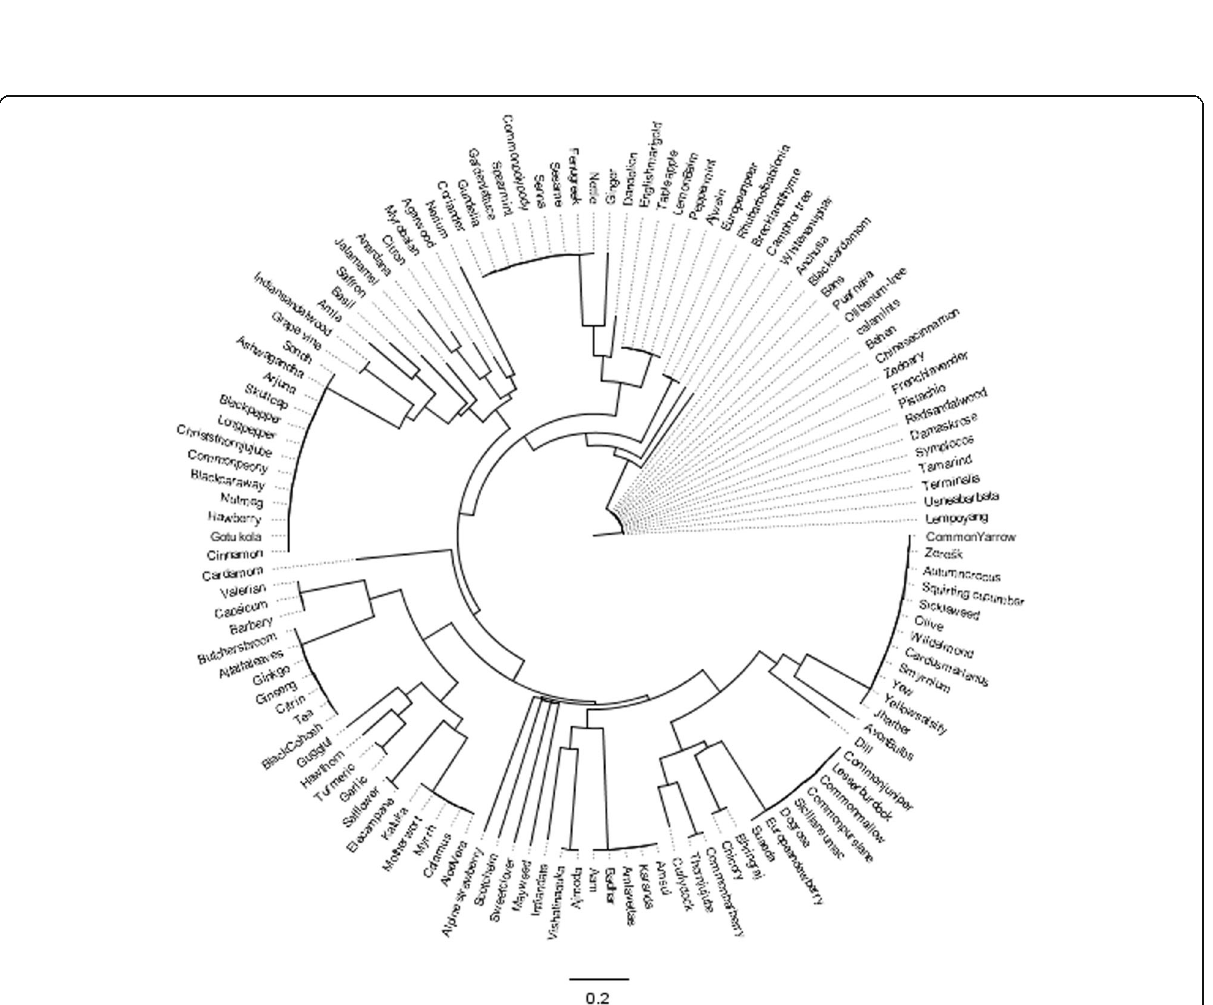
Fig. 2 The dendogram depicts 128 different medicinal plants having property to cure some type of heart disease/ailment. The medicinal plants in one group shows that they have similar properties to cure same heart disease. The distance in dendogram depicts closeness of properties curing heart disease; as less the distance between two medicinal plants or two groups they will more close to cure particular heart